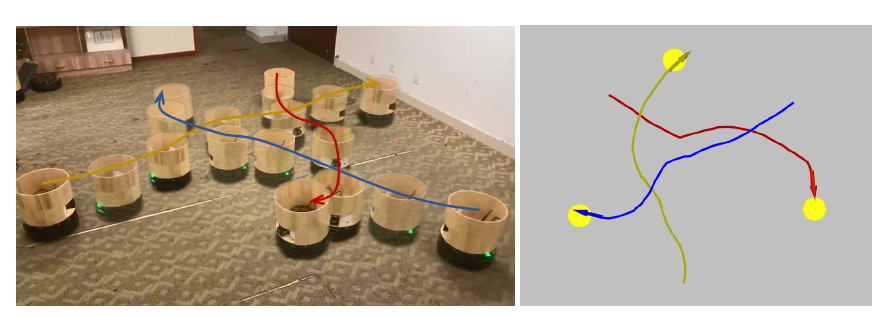
Figure 17. ( a ) Two-robot swap scenario, where two robots are required to move towards each other and swap their positions. ( b ) Extended two-robot cross scenario, which is extended from the two-robot cross scenario by randomly placing some static obstacles. ( c ) Two-robot cross scenario with a pedestrian, where a pedestrian is asked to walk across the paths of both robots. ( d ) Three-robot circle scenario, where three robots are placed on a circle and their targets are set at opposite positions. Subfigures on the left show the trajectories of the robots in the real world. Subfigures on the right show the trajectories recorded by robots based on their own localizations. Notice that the trajectories recorded by robots are not that smooth which is mainly due to the low accuracy of the robots’ localizations. Lines with different colors denote trajectories of different